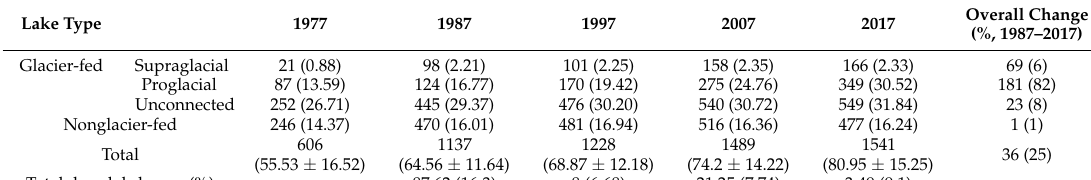
Table 3. Total number of glacial lakes by type between 1977 and 2017 with total decadal and overall change (%). The values in parentheses indicate the total surface area (km 2 ).